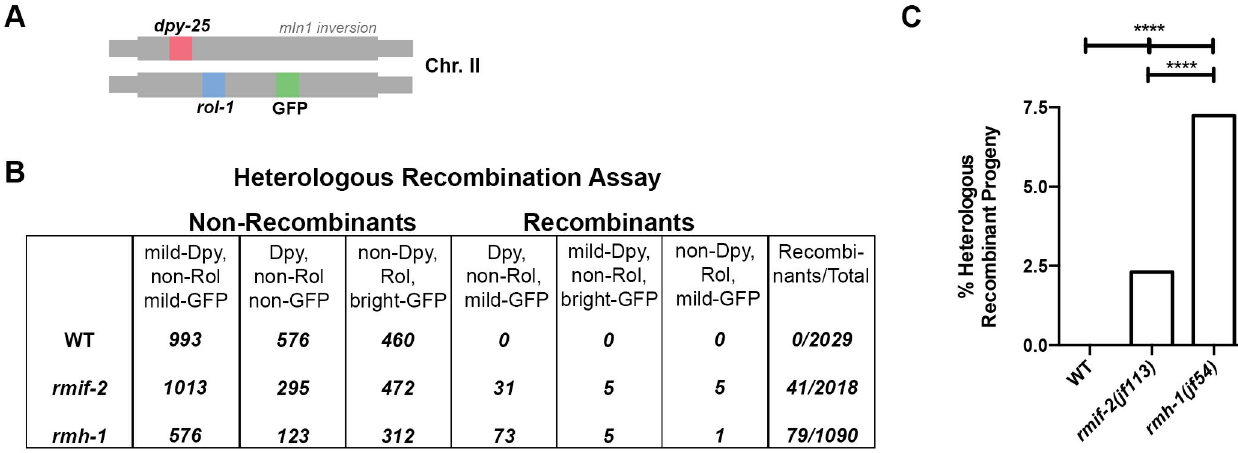
Fig 8. RMH-1 and RMIF-2 suppress heterologous recombination to different extents. (A) A heterologous recombination assay [12] was used to determine the involvement of rmh-1 and rmif-2 in suppressing illegitimate recombination events. The method used to score heterologous recombination relies on the use of the mIn1 inversion on chromosome II (scoring for the exchange of shown genetic markers). (B) In WT (n = 2029 worms), no heterologous recombination was observed among the progeny; rmif-2 (n = 2018) 41 recombinant progeny; rmh-1 (n = 1090), 79 recombinant progeny. (C) Rate of heterologous recombinant progeny: WT, 0%; rmif-2 , 2.3%; and rmh-1 , 7.24%. The level of heterologous recombination in the rmh-1 mutant is around three times higher than in the rmif-2 mutant. Statistical analysis was done with a Fisher’s exact test: WT vs rmif-2 ���� (p < 0.0001); WT vs rmh-1 ���� (p < 0.0001); rmif-2 vs rmh-1 ���� (p < 0.0001).